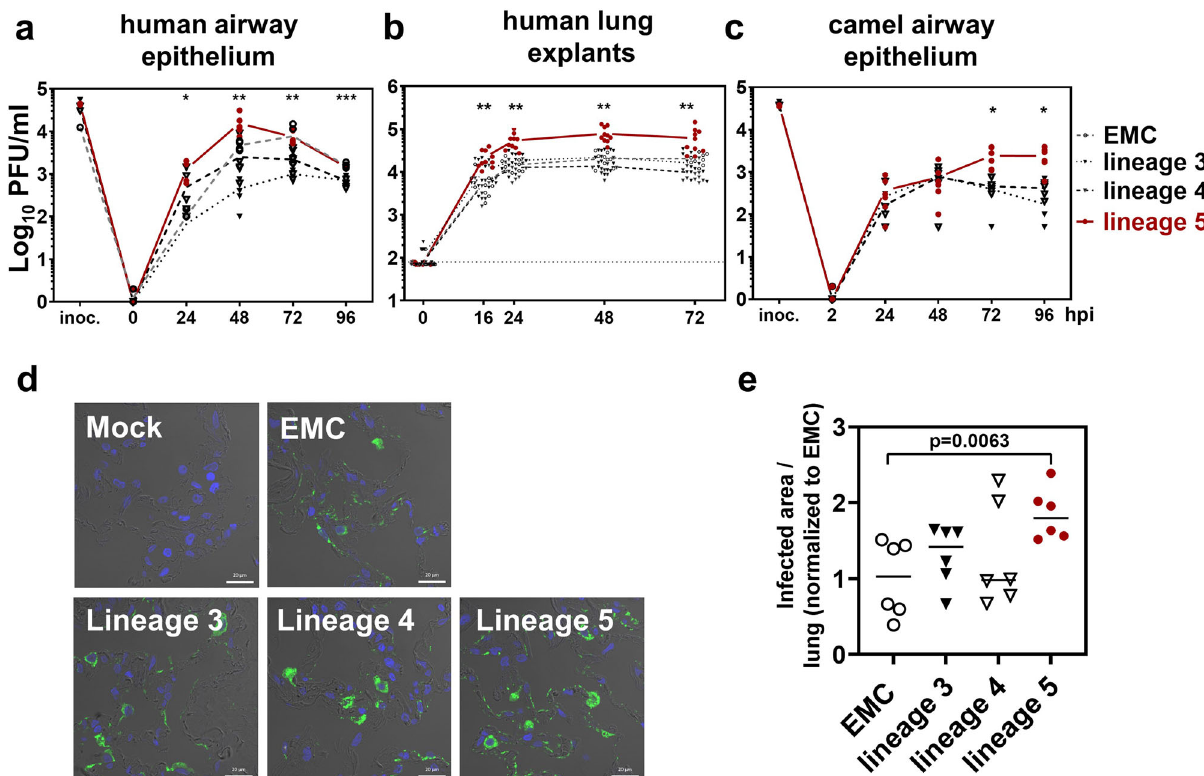
Fig. 10 Growth kinetics of MERS-CoV isolates in models of the human and camel respiratory tract. a Replication on primary human airway epithelium (HAE) of a single donor. Two isolates of each phylogenetic lineage were used for infection in biological triplicates. Virus progeny in apical washes was quanti fi ed every 24 h by plaque assay. Statistical signi fi cance in difference of PFU/ml between lineage 5 and other lineages was determined by one-way ANOVA and two-tailed Student´s t -test for each time point individually. Statistically signi fi cant differences in PFU/ml determined by one-way ANOVA corrected for multiple comparisons using the Tukey method were found at 24 hpi (lineage 5 vs. lineage 3: *; p = 0.0274; lineage 5 vs. EMC: *; p = 0.0301); at 48 hpi (lineage 5 vs. lineage 3: *; p = 0.0248; lineage 5 vs. lineage 4: *; p = 0.0398); at 72 hpi (lineage 5 vs. lineage 3: **; p = 0.0095; lineage 5 vs. lineage 4: *; p = 0.0190) and at 96 hpi (lineage 5 vs. lineage 3: ****; p < 0.0001; lineage 5 vs. lineage 4: *; p = 0.0123; lineage 5 vs. EMC: **; p = 0.0050) b Replication of MERS-CoV isolates on ex vivo lung explants, derived from n = 3 different patients that have undergone lung resection. One isolate of each phylogenetic lineage was used for infection in biological triplicates for each explant and virus progeny in the supernatant was quanti fi ed by plaque assay. Differences in PFU/ml between lineage 5 and other lineages was tested for signi fi cance using the two-sided Kruskal – Wallis test. Statistically signi fi cant differences in PFU/ml were found at 16 hpi (lineage 5 vs. EMC: **; p = 0.0024; lineage 5 vs. lineage 4: **; p = 0.0012), at 24 hpi (lineage 5 vs. EMC: ***; p = 0.0006; lineage 5 vs. lineage 3: **; p = 0.0080; lineage 5 vs. lineage 4: ****; p < 0.0001), at 48 hpi (lineage 5 vs. EMC: **; p = 0.0064; lineage 5 vs. lineage 3: **; p = 0.0034; lineage 5 vs. lineage 4: ****; p < 0.0001) and at 72 hpi (lineage 5 vs. lineage 3: **; p = 0.0029; lineage 5 vs. lineage 4: ****; p < 0.0001) c Replication of MERS-CoV isolates on well-differentiated primary Bactrian camel airway epithelium. Two isolates of each phylogenetic lineage were used for infection in biological triplicates. Virus progeny in apical washes was quanti fi ed every 24 h by plaque assay. Statistical signi fi cance in difference of PFU/ml between lineage 5 and other lineages was determined by one-way ANOVA and two-tailed Student´s t -test for each time point individually. Statistically signi fi cant differences in PFU/ml were found at 72 hpi (lineage 5 vs. lineage 3: *; p = 0.0222; lineage 5 vs. lineage 4: *; p = 0.0266 and at 96 hpi (lineage 5 vs. lineage 3: *; p = 0.0144; lineage 5 vs. lineage 4:*; p = 0.0244). d Immuno fl uorescent analysis of MERS-CoV lineages replication in ex vivo human lung tissue. Explants from n = 3 different patients were infected with one MERS-CoV isolate of each lineage for 24 h. Histological sections were probed with MERS-CoV nucleocapsid antibody (green), nuclei were counterstained with DAPI (blue), and tissue structure was visualized by differential interference contrast. Scale bar represents 20 µ M. e MERS-CoV replication quanti fi ed by immuno fl uorescent analysis. Values represent the area (in µ m 2 ) of positive-infection, determined by nucleocapsid immuno fl uorescent signal in n = 3 infected lung explants at 24 hpi, measured in biological duplicates. The complete piece of each lung explant was analyzed for quanti fi cation. The positive-infected area of each respective isolate was normalized to the total lung tissue area and the value obtained for the EMC strain-infected lung tissue. Statistical signi fi cance in a quanti fi ed infected area between lineage 5 and EMC was analyzed by two-tailed, unpaired t -tests. Scale bar = 20 µ m. PFU, plaque forming